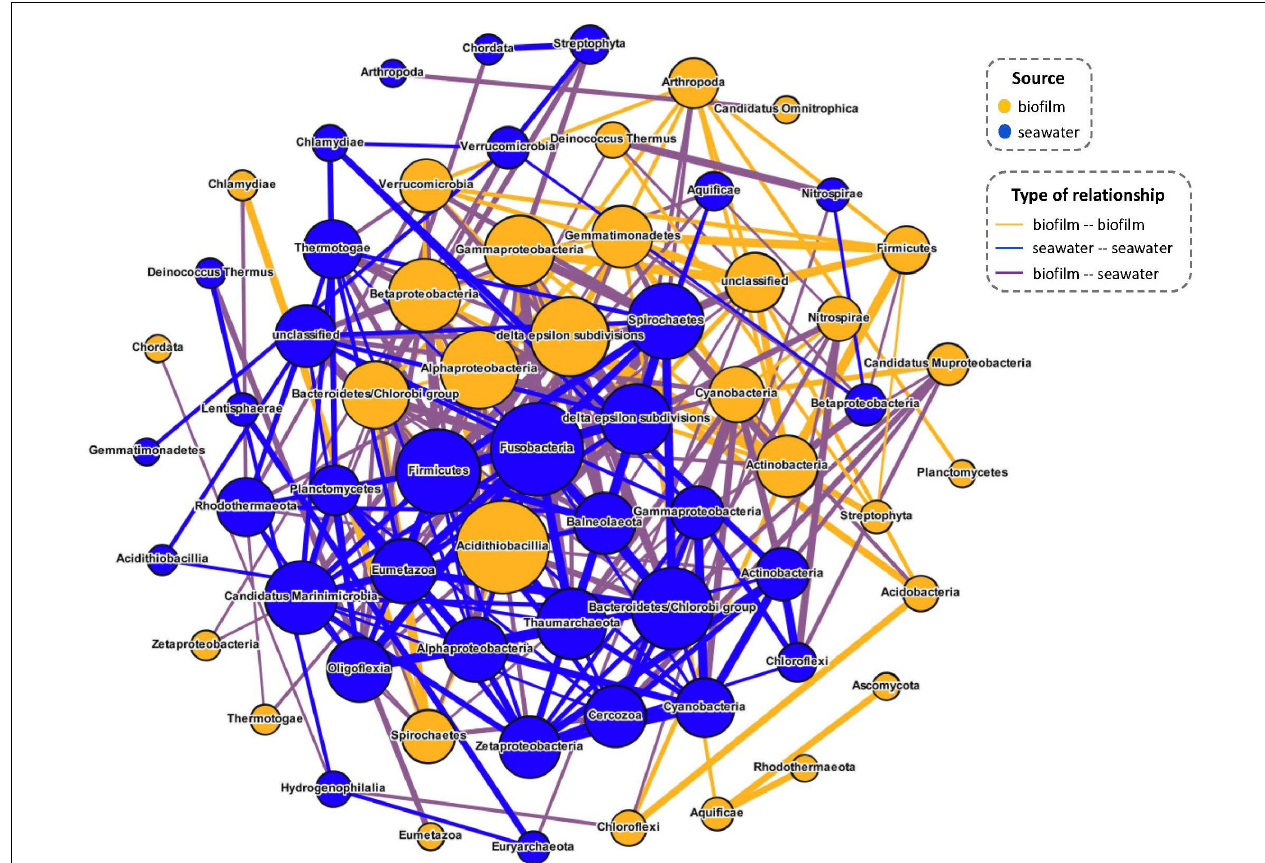
FIGURE 5 | Co-occurrence network of signal transduction gene source phyla (classes of proteobacteria) in the Red Sea biofilms and seawater microbial communities. The size of each node is proportional to its number of connections, and the thickness of lines represents the absolute value of correlation